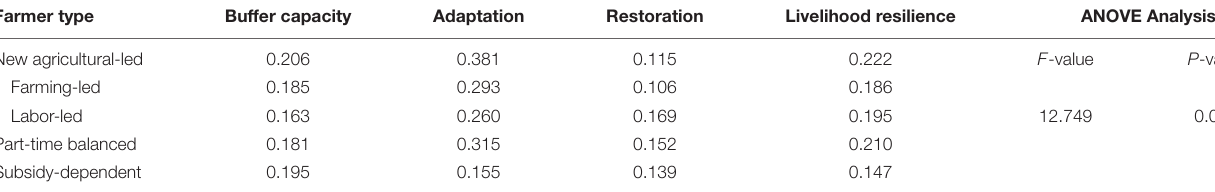
TABLE 3 | Livelihood resilience index for each type of farm household and ANOVE analysis. Farmer type